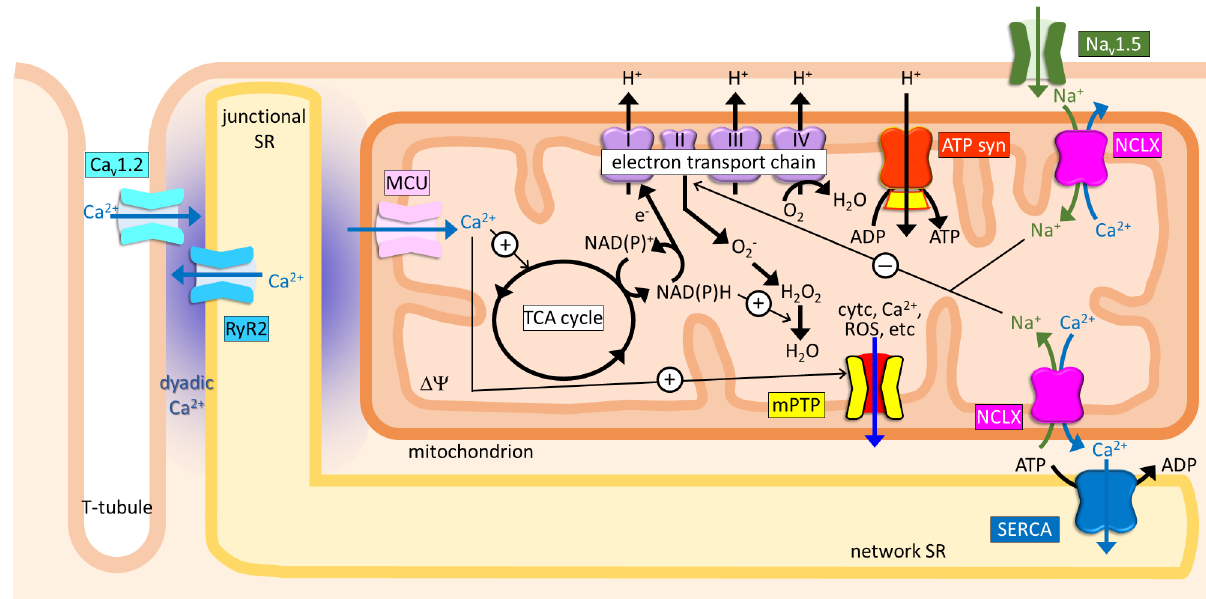
Figure 2. An overview of the NCLX-mediated physiological and pathophysiological functions in a cardiomyocyte. ATPsyn, F 1 F o -ATP synthase; Ca v 1.2, L-type Ca 2+ channel; cytc, cytochrome c; ∆Ψ , mitochondrial membrane potential; MCU, mitochondrial Ca 2+ uniporter complex; mPTP, mitochondrial permeability transition pores; Na v 1.5, voltage-dependent Na + channel; ROS, reactive oxygen species; RyR2, ryanodine receptor 2; SERCA, sarcoplasmic reticulum Ca 2+ pump; SR, sarcoplasmic reticulum; TCA, tricarboxylic acid.